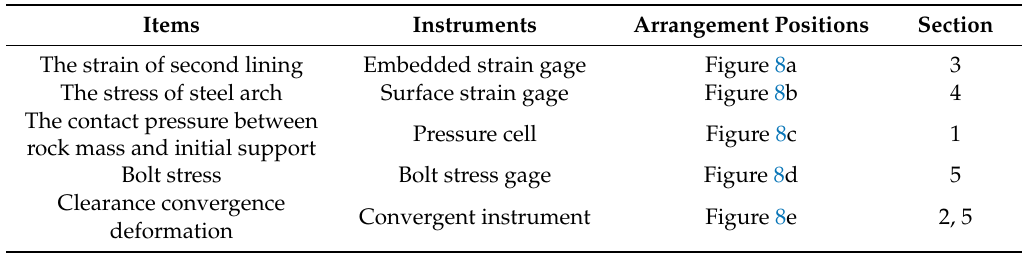
Figure 8. The instrument arrangement positions on monitoring section: ( a ) strain of second lining; ( b ) strain of steel arch; ( c ) contact pressure between rock mass and initial support; ( d ) bolt stress; ( e ) clearance convergence deformation. Table 2. Field test items and methods.